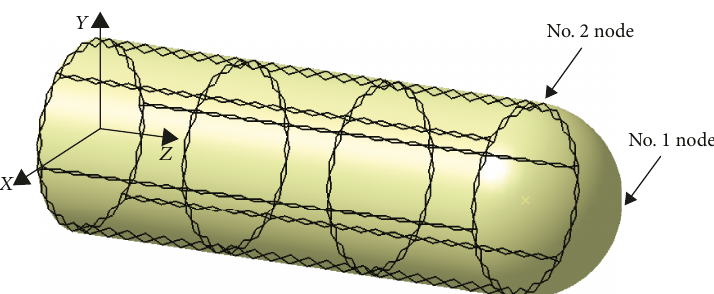
Figure 1: Model of deployable habitat module unit.